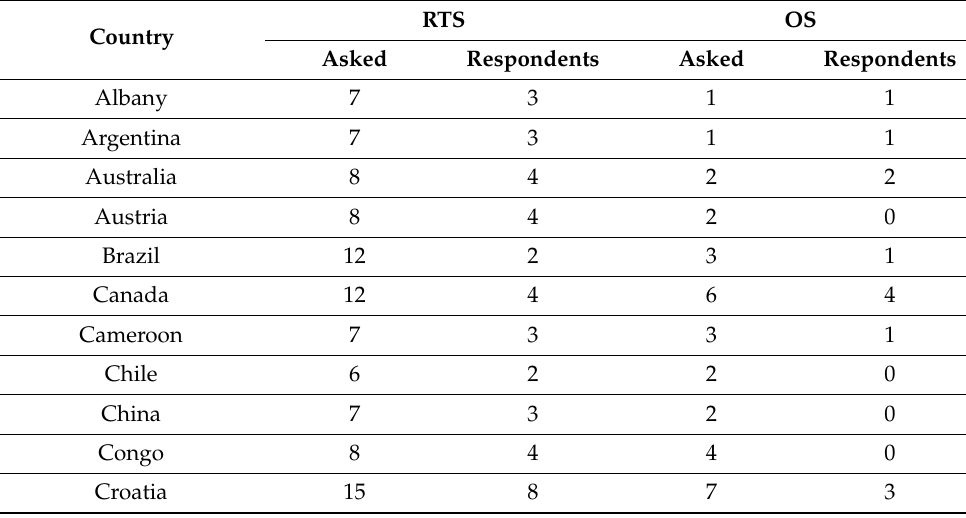
Table 3. Details of the